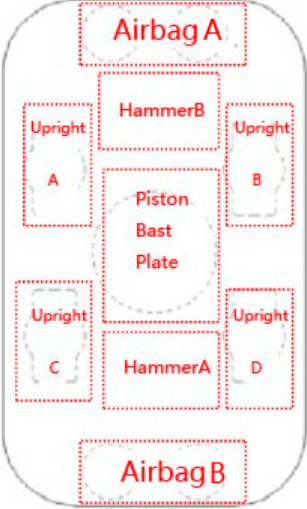
Figure 8. Regional location and labeling of the vibrator plate.